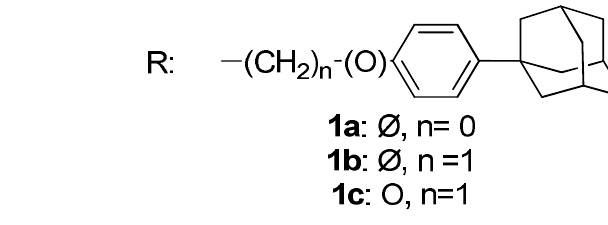
Figure 2. Tautomers of hydroxamic acids 1a – c.